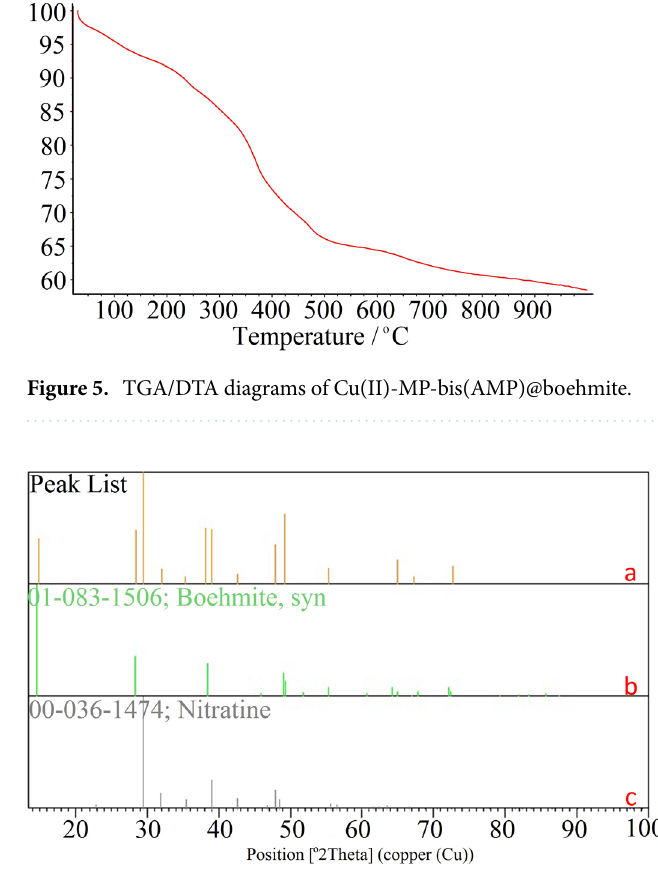
Figure 6. XRD pattern of Cu(II)-MP-bis(AMP)@boehmite ( a ), standard pattern 01-083-1506 code of boehmite ( b ) and standard pattern 00-036-1474 code of sodium nitrate ( c ).